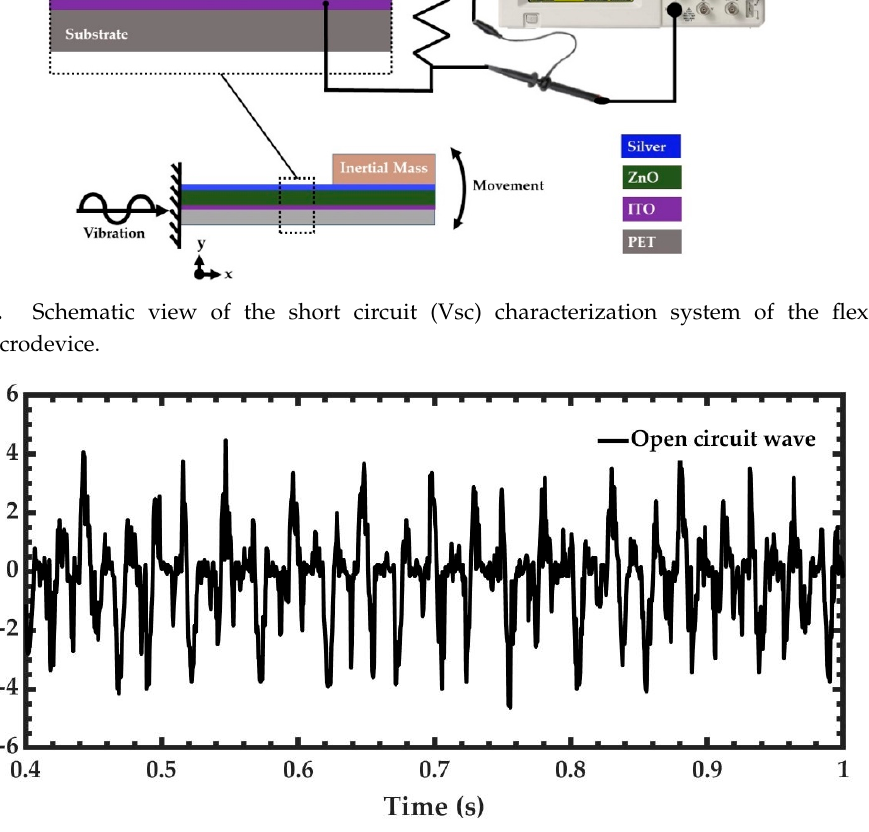
Figure 8. Output voltage of the pVEH microdevice under mechanical vibrations at 37 Hz and 1.5 g acceleration.